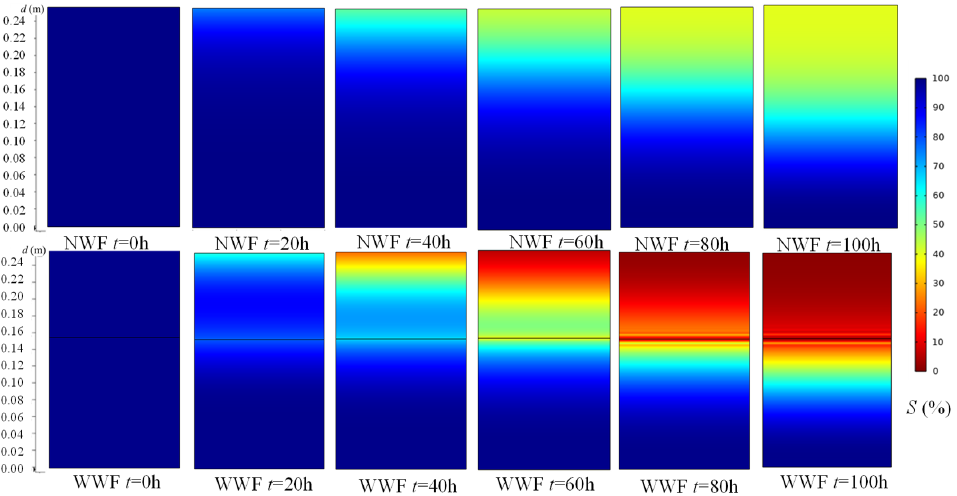
Figure 9. Comparison of saturation distribution for Tomakomai soil between NWF model and WWF model in the freezing process.